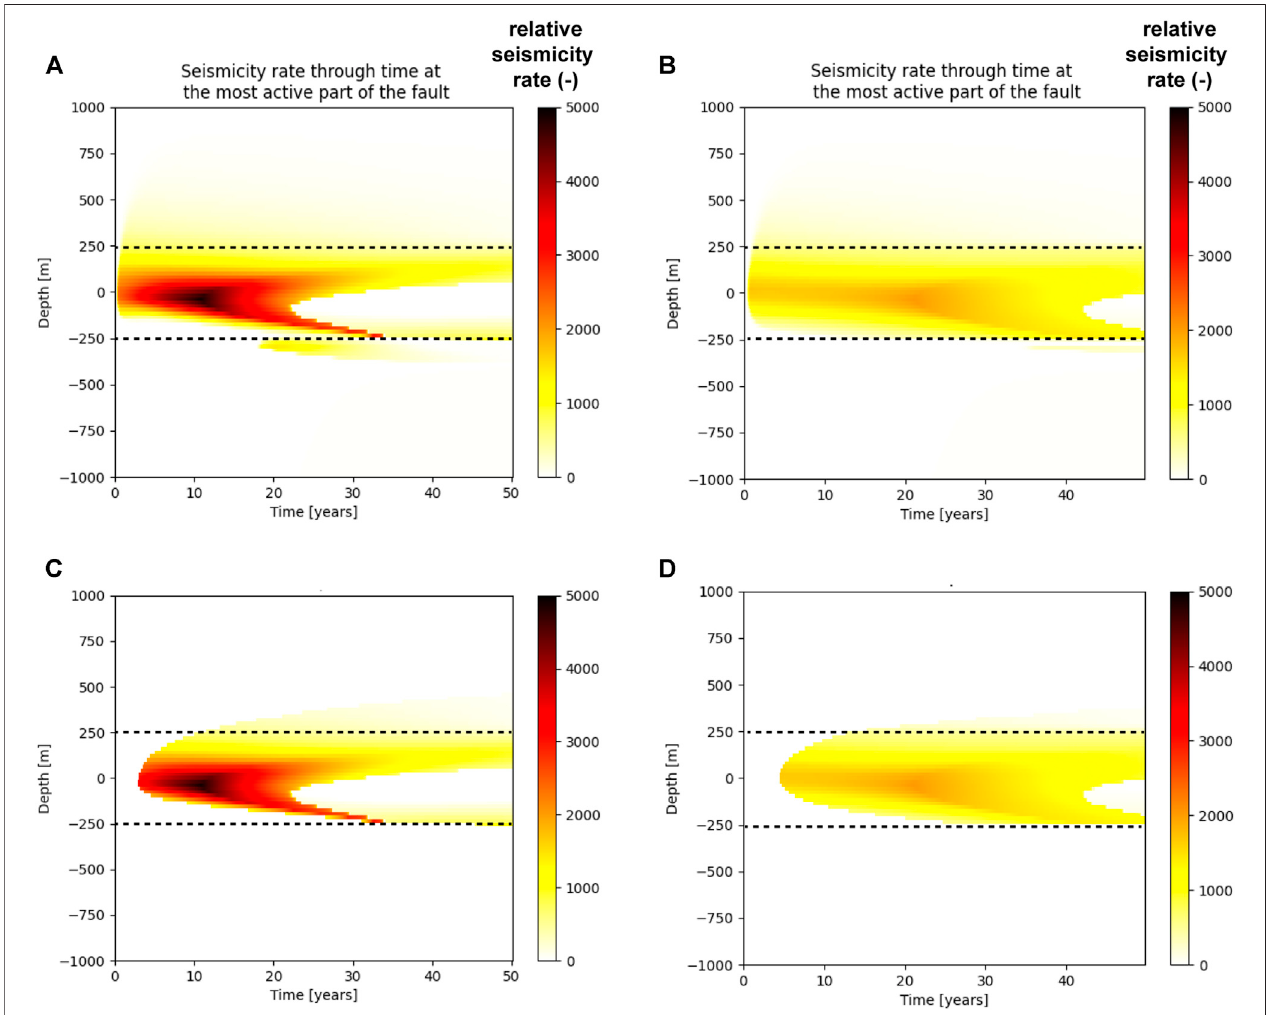
FIGURE 6 | Relative seismicity rates versus time after onset of injection for (A) 2 m fracture spacing uncorrected for the size of the perturbed area and (B) 200 m fracturespacinguncorrected forthesizeoftheperturbedarea, (C) 2 mfracturespacing, spatialdistribution iscorrectedforthesizeoftheperturbed areaand (D) 200 m fracture spacing, spatial distribution is corrected for the size of the perturbed area. Dashed lines indicate top and bottom of reservoir layer. Mid-height reservoir at 0 m, unitsindepth(m)alongdip.Locationofprojectedinjectionwellaty (cid:2) 0.Relativeseismicityrates( R )areshownforoneparticularrealization,withf crit (cid:2) 0.4, M min (cid:2) -1, A (cid:2) 0.001 and _ τ 0 (cid:2) 0.0002 and b (cid:2) 1.